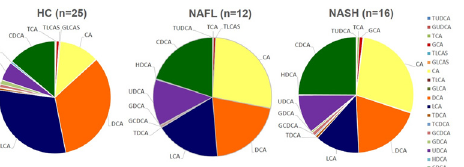
Fig 1. Changes in fecal bile acid composition in HC, NAFL and NASH